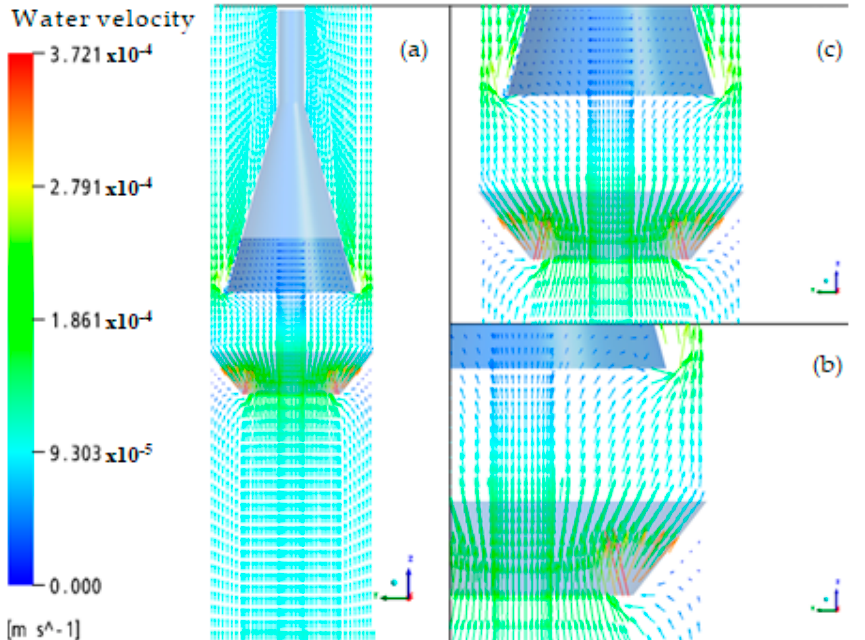
Figure 8. Sludge velocity vector in the reactor with deflector inclination upwards: ( a ) overview, ( b ) detail of the region between the gas deflector and the three-phase separating element, and ( c ) detail of the region corresponding to the settling zone.